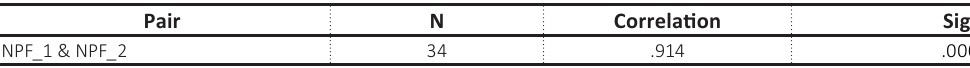
Table A12. Paired samples test (the result of H3b )